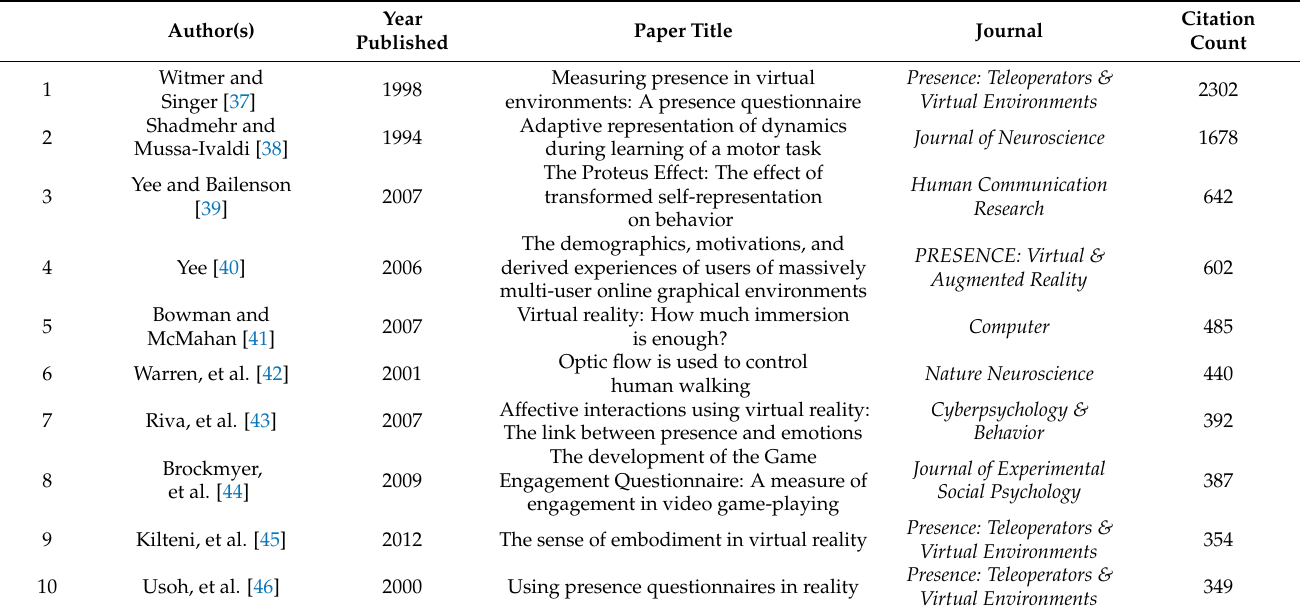
Table 2. The top 10 most-cited papers in WoS search results for embodied experience in